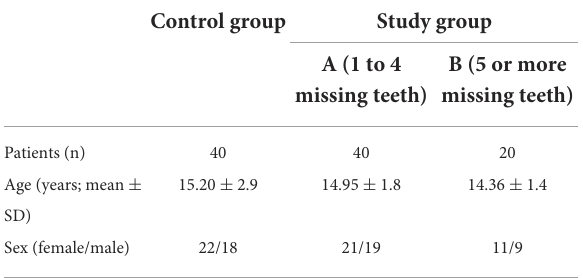
TABLE 4 Distribution of subjects by groups.